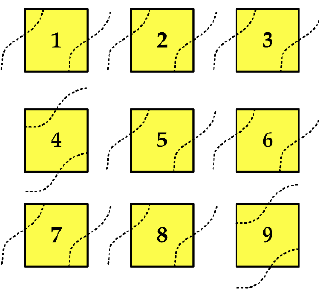
Figure 8. Electric field distribution of the reconfigurable microstrip antenna.